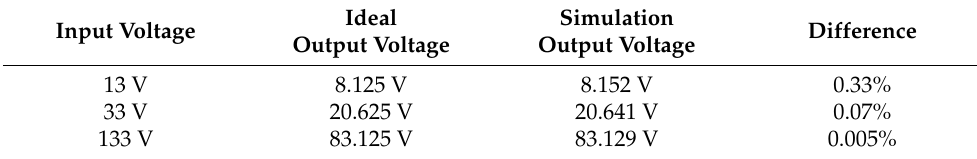
Table 7. Simulation results by optimum parasitic